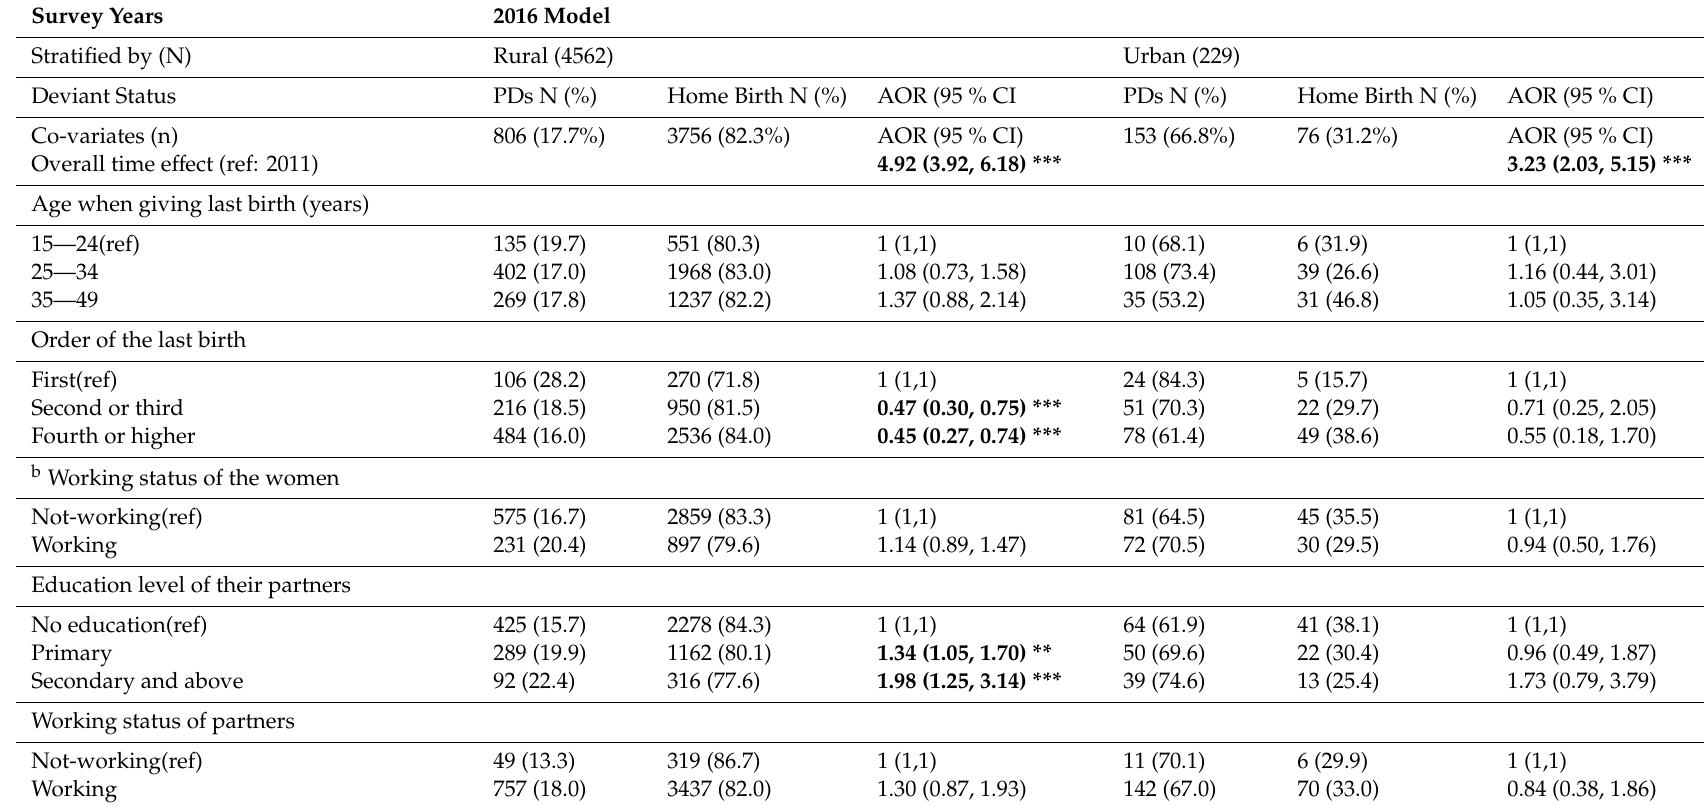
Table 5. Results of multiple multilevel logistic regression exploring factors associated with being a positive deviant for having a health facility delivery among urban and rural women, 2016 Ethiopia